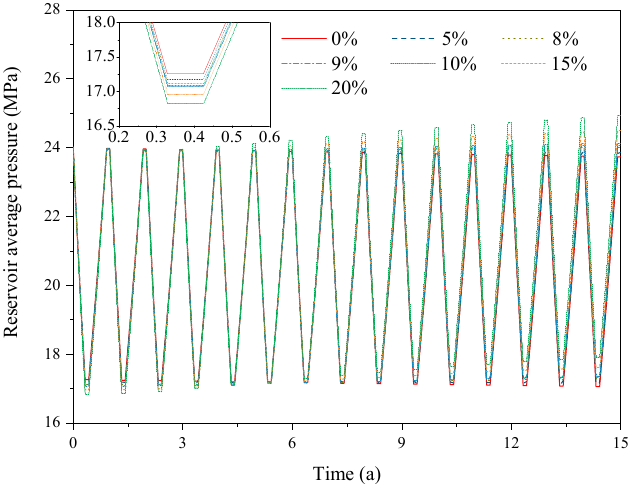
Figure 6. Average reservoir pressure for the underground gas storage reservoirs (UGSRs) with different concentrations of cushion gas CO 2 .